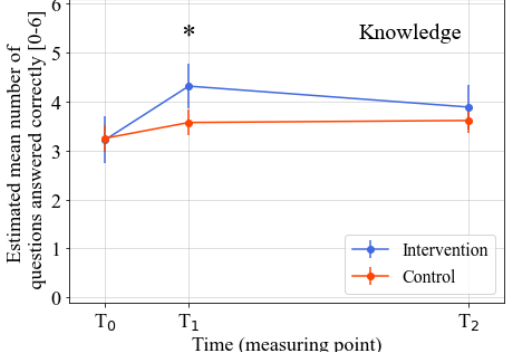
Figure 2. Estimated marginal means of the number of questions answered correctly from T0–T2.